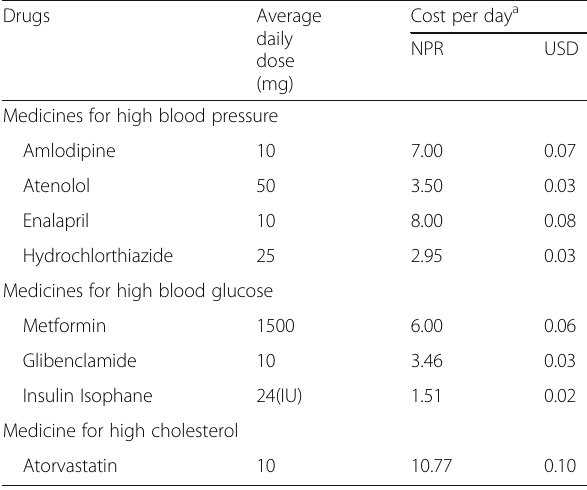
Table 3 Daily cost of WHO Global Hearts